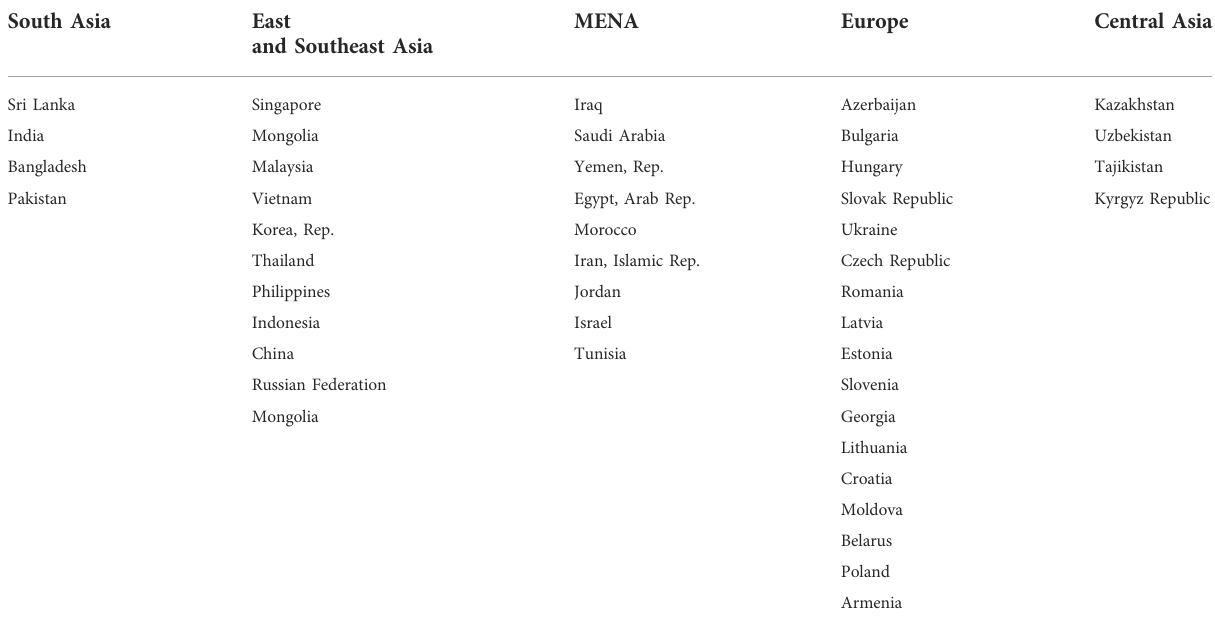
TABLE 1 List of a selected panel of BRI